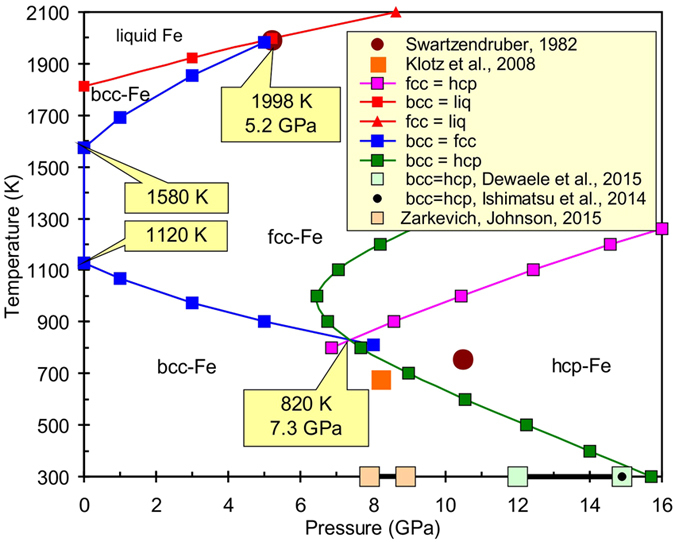
Calculated phase diagram of iron at pressures up to 16 GPa in comparison with reference data711686970.